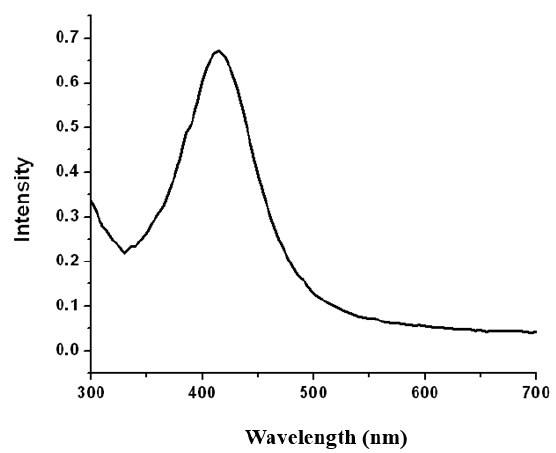
Figure 2. Ultraviolet–visible (UV-vis) spectrum of CS/AgNp solution.